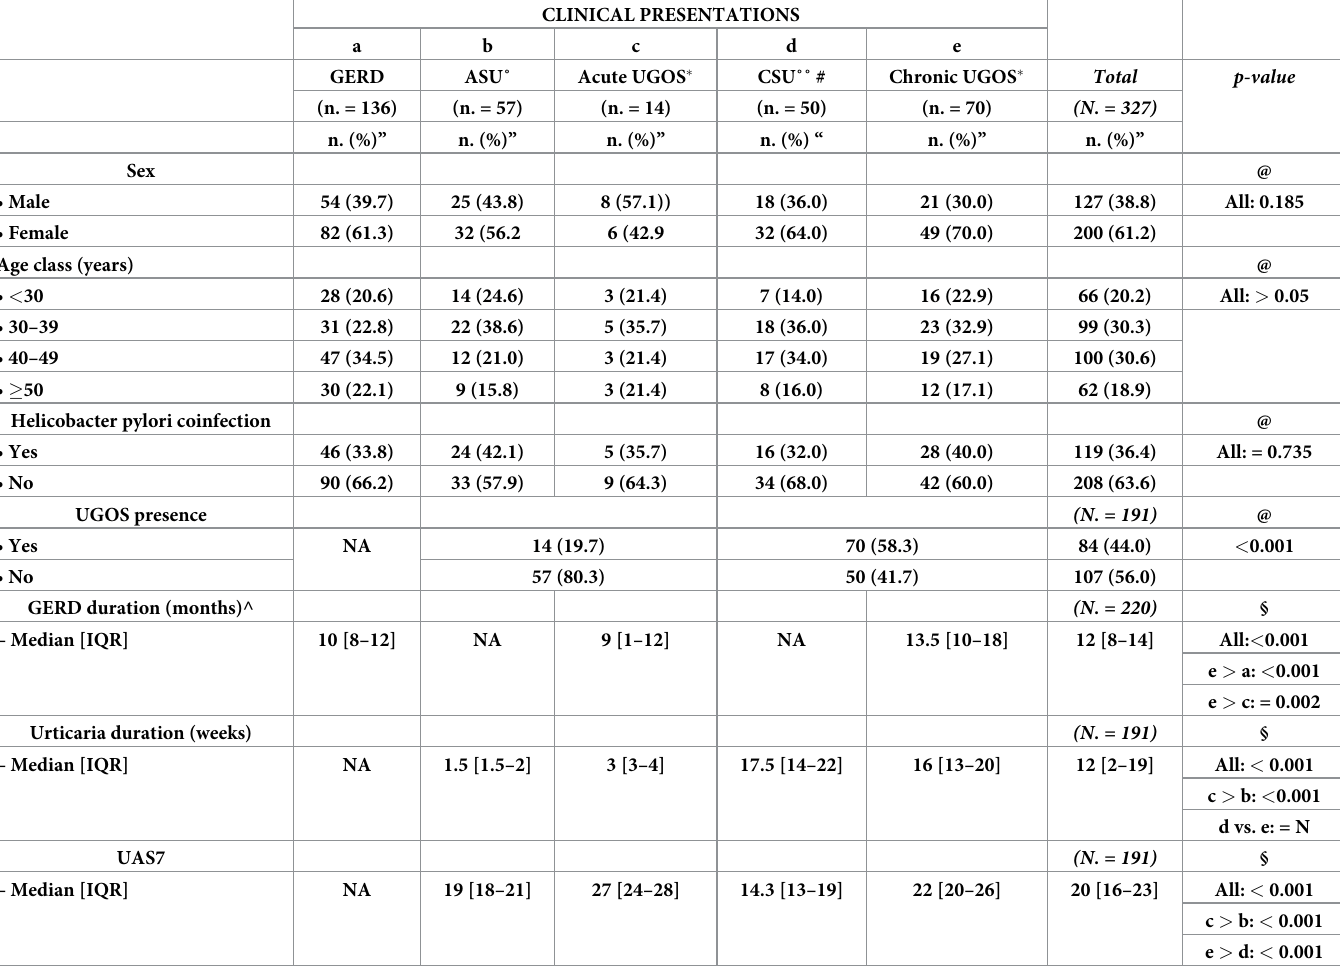
Table 3. Demographic and clinical features of patients suffering from gastroesophageal reflux disease (GERD) and/or urticaria according to different clinical presentations. CLINICAL